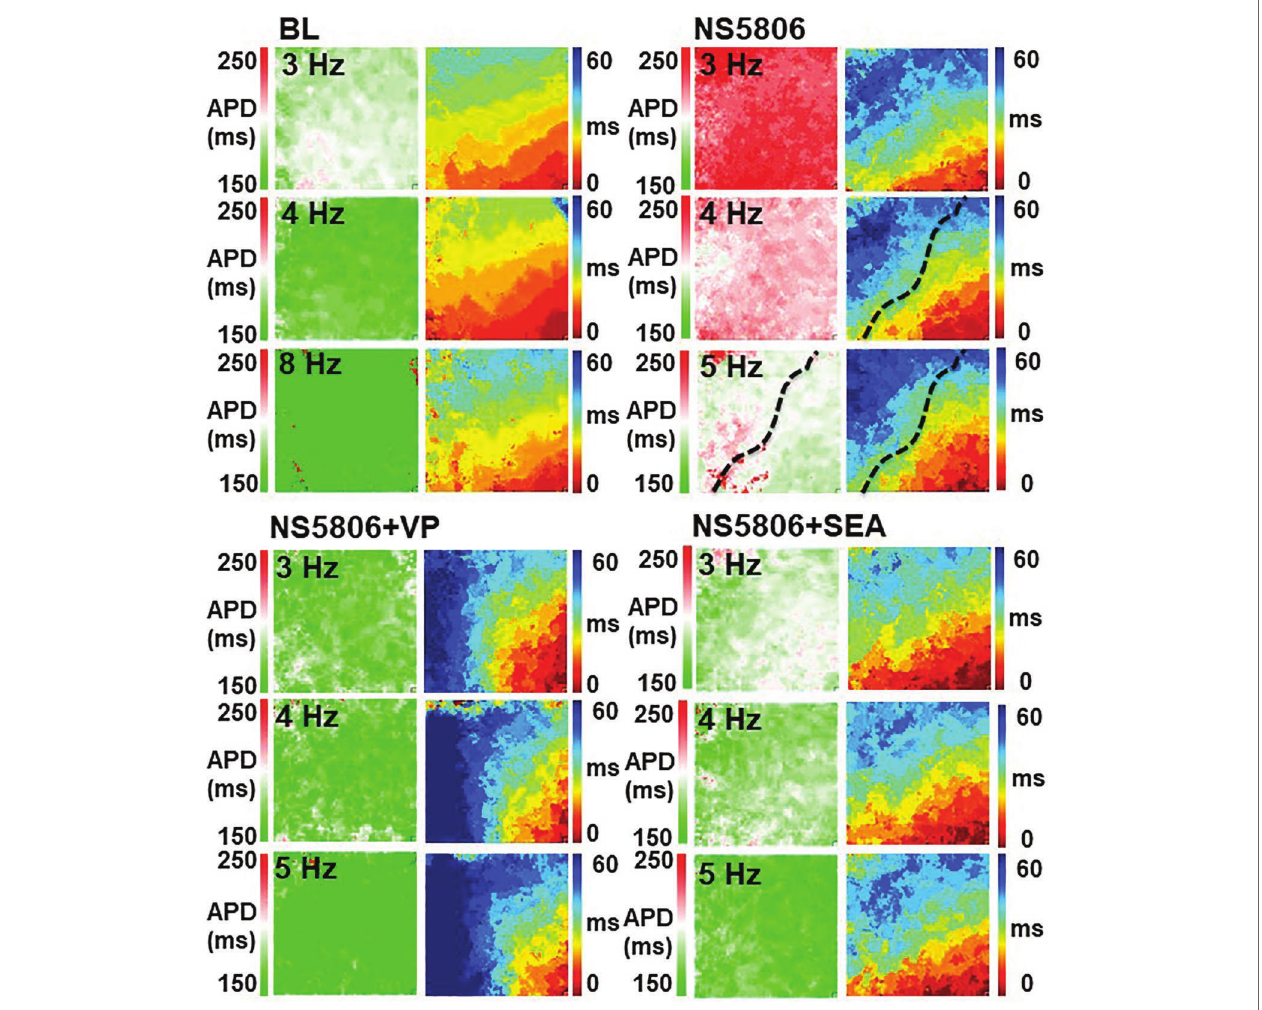
FIGURE 3 | APD and isochronal maps of paced propagations under different conditions. Spatial variations in APD and CV occurred after infusion of NS5806, particularly at high pacing frequency, which were modulated by the addition of other drugs. This heterogeneous phenomena were augmented by VP and mitigated by SEA. At faster rates, CV slowing and APD prolongation became more apparent in the RV (to the right of the dotted line that represents the left anterior descending artery). Of note, APD maps are shown in same time scale to appreciate the APD prolongation with